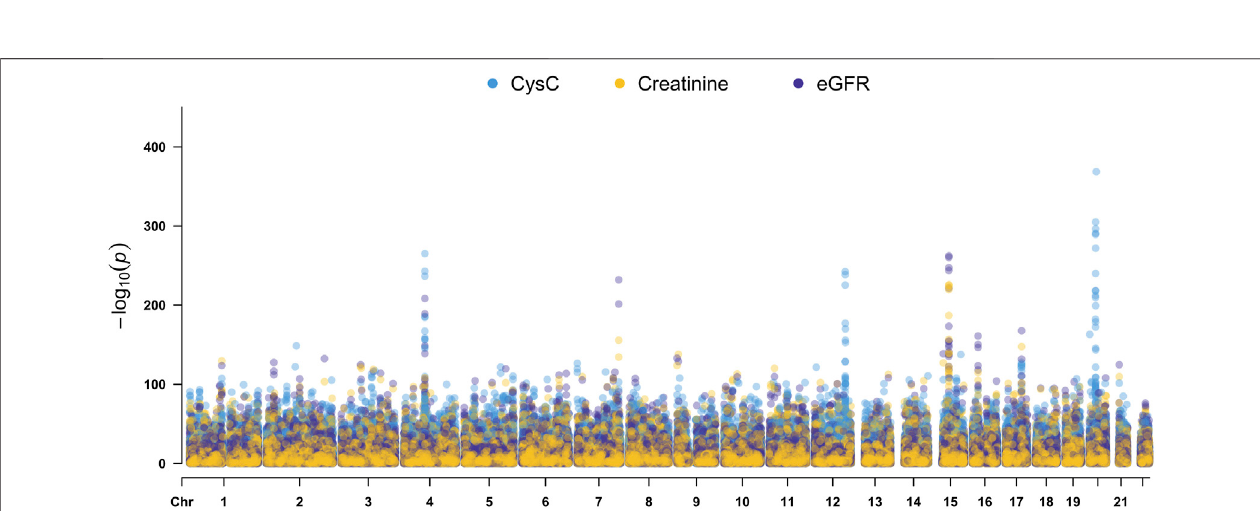
Frontiers in Genetics |